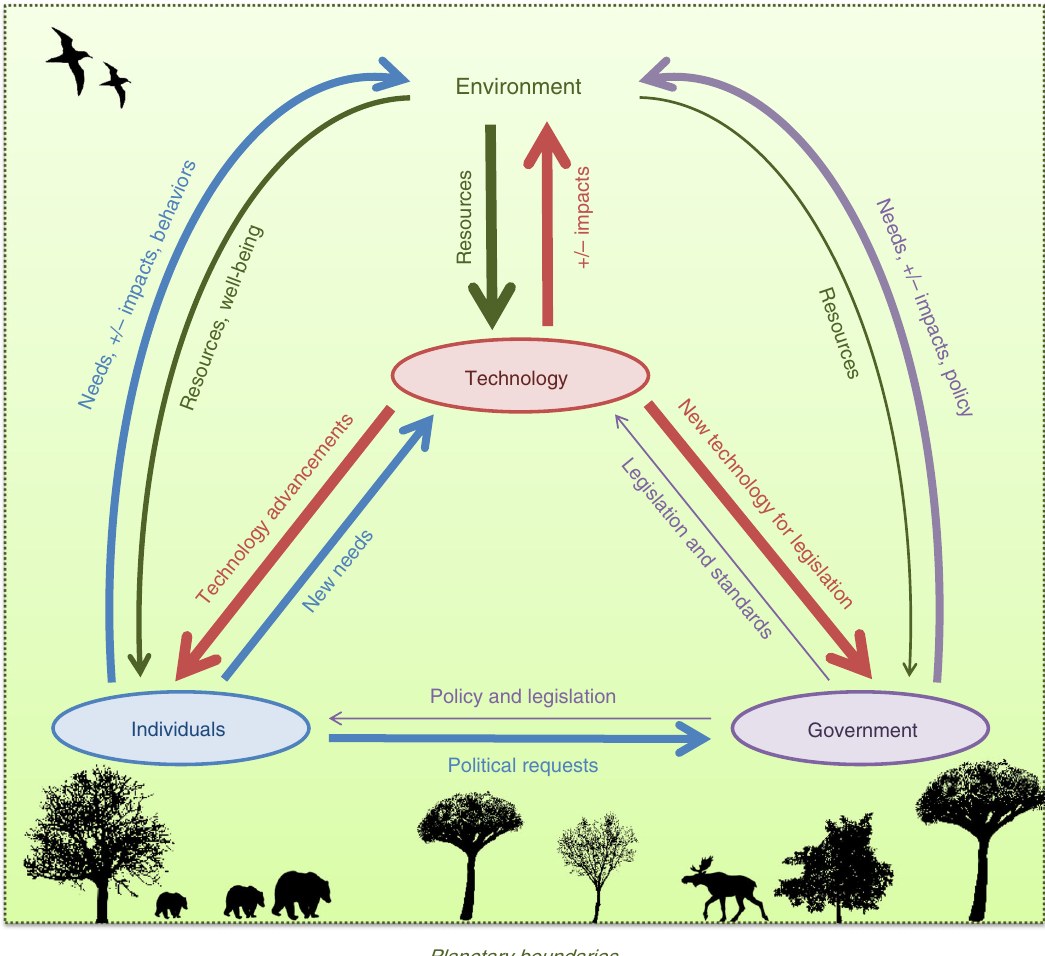
Fig. 5 Interaction of AI and society. Schematic representation showing the identi fi ed agents and their roles towards the development of AI. Thicker arrows indicate faster change. In this representation, technology affects individuals through technical developments, which change the way people work and interact with each other and with the environment, whereas individuals would interact with technology through new needs to be satis fi ed. Technology (including technology itself and its developers) affects governments through new developments that need appropriate piloting and testing. Also, technology developers affect government through lobbying and in fl uencing decision makers. Governments provide legislation and standards to technology. The governments affect individuals through policy and legislation, and individuals would require new legislation consistent with the changing circumstances from the governments. The environment interacts with technology by providing the resources needed for technological development and is affected by the environmental impact of technology. Furthermore, the environment is affected either negatively or positively by the needs, impacts, and choices of individuals and governments, which in turn require environmental resources. Finally, the environment is also an underlying layer that provides the “ planetary boundaries ” to the mentioned